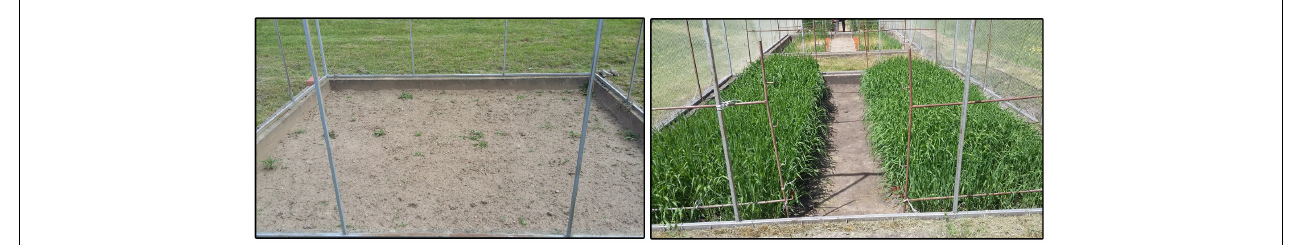
FIGURE 1 | Example of the experimental microplots, before sowing (left), spring (right).